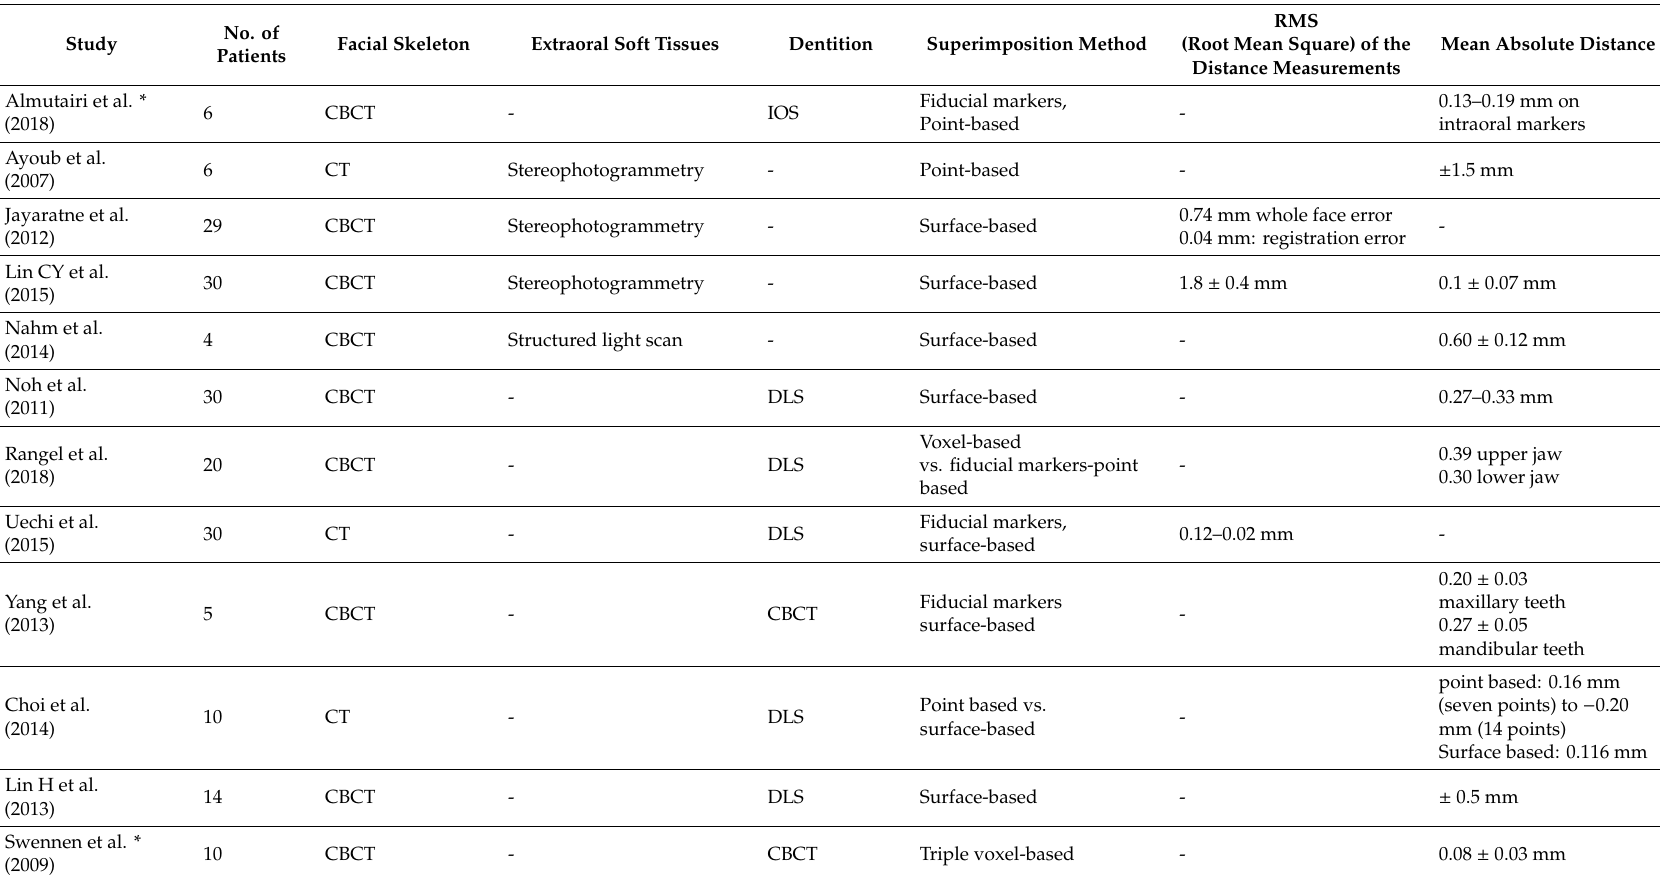
Table 2. Information on the studies that analyzed the reliability of the